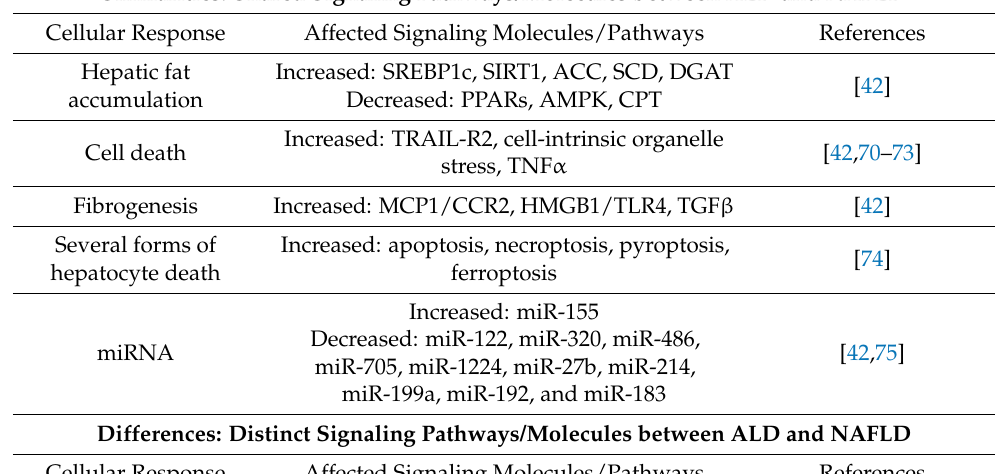
Table 1. The similarities and differences in cellular response and affected signaling pathways between ALD and NAFLD during disease